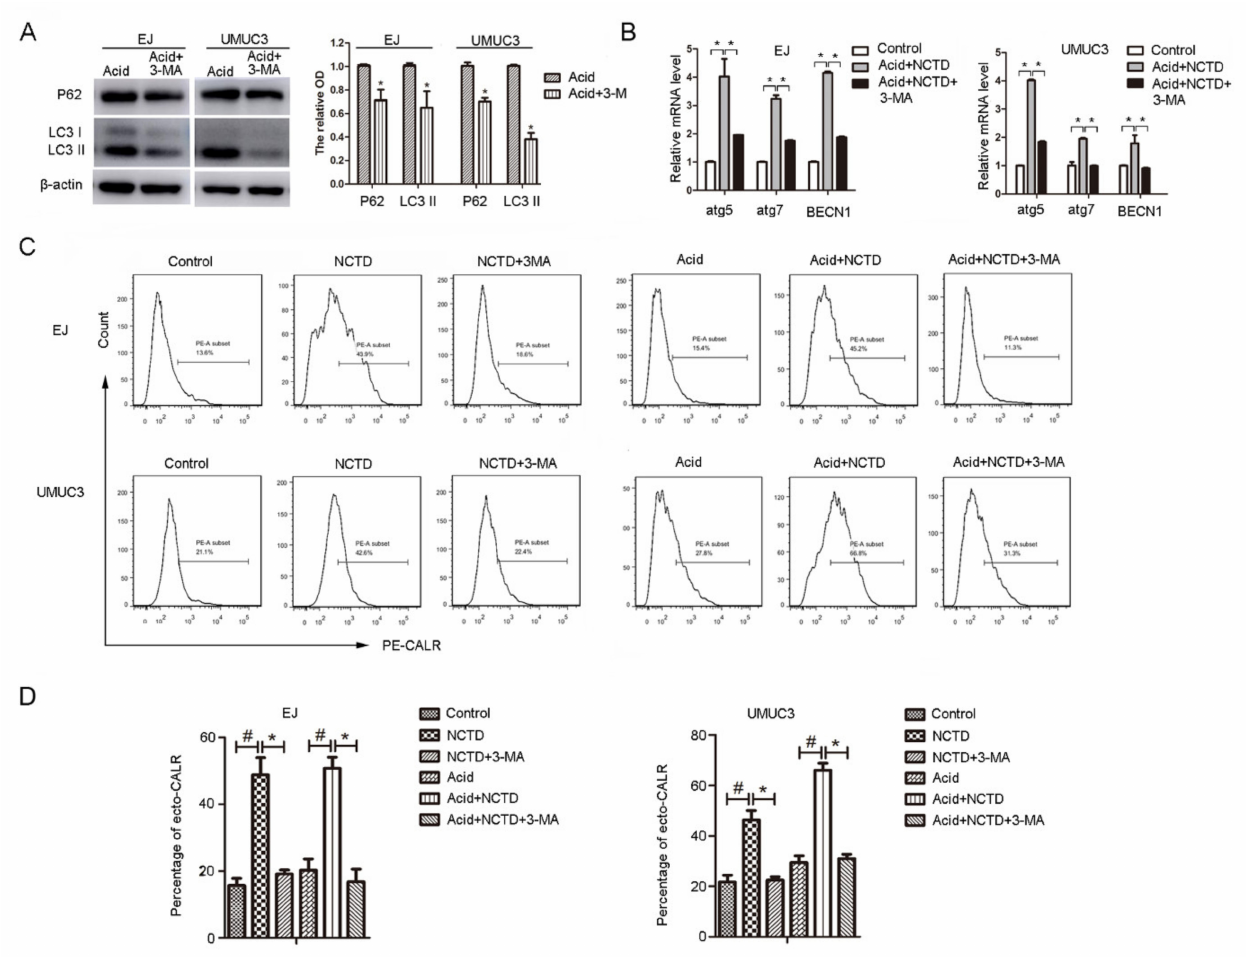
Figure 6. Inhibition of autophagy decreased the ecto-CALR induced by NCTD. ( A ) EJ and UMUC3 Cells were exposed to 3MA (5 mM) in acidic medium, P62 and LC3 protein levels were evaluated by Western blotting, β -actin was used as an internal control and relative protein levels were measured. ( B ) Cells were treated with NCTD (3 µ M) with or without 3-MA (5 mM) in acidic medium for 24 h, mRNA levels of atg5, atg7, and BECN1 were detected by Real-time PCR. Data are presented as the mean ± SD ( n = 3), * p < 0.05 vs. the acid group. ( C ) Flow cytometry analysis of ecto-CALR exposure on the cells treated with NCTD with or without 3-MA (5 mM) in physiological and acidic culture. ( D ) Quantification of the percentage of ecto-CALR. Data are presented as the mean ± SD ( n = 3), * p < 0.05 vs. the NCTD group, # p < 0.05 vs. the control